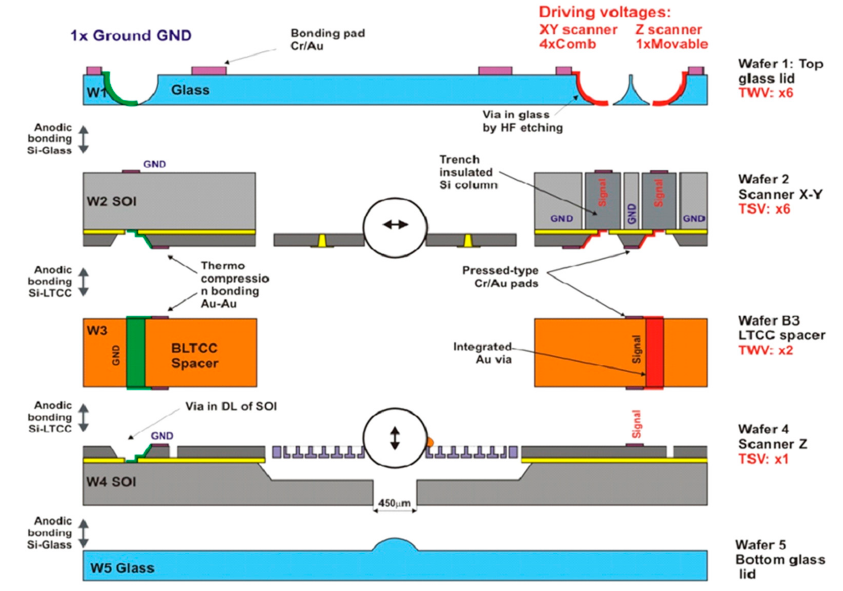
Figure 20. Details of the vertical integration strategy—cross-sectional view of 3D microscanner.